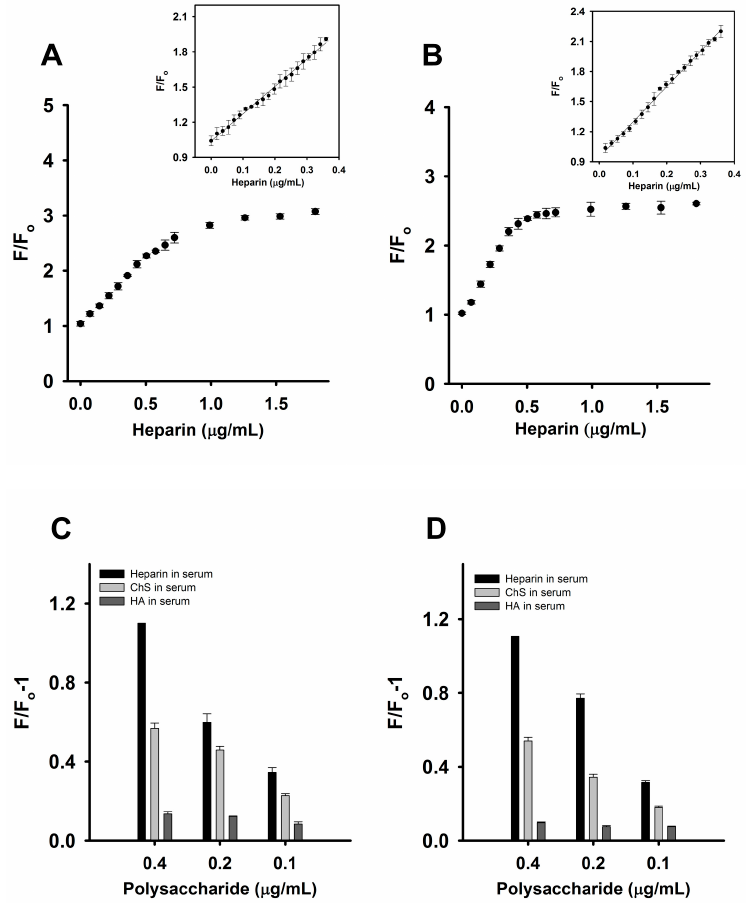
Figure 10. Determination of heparin in plasma samples: Fo and F corresponded to the fluorescence intensity of FAM at 520 nm in the absence or presence of heparin, respectively. ( A ) changes in the fluorescence intensity of solutions of 20 nM aptamer and 300 nM CTX3 in the presence of heparin-spiked plasma samples. (Inset) A plot of the F/Fo value versus the spiked concentrations of heparin; ( B ) changes in the fluorescence intensity of solutions of 10 nM MB and 200 nM CTX3 in the presence of heparin-spiked plasma samples. (Inset) A plot of the F/Fo value versus the spiked concentrations of heparin. Changes in the fluorescence intensity of ( C ) CTX3-aptamer and ( D ) CTX3-MB sensors upon the addition of heparin-, ChS- and HA-spiked plasma samples. Fo and F corresponded to the fluorescence intensity at 520 nm of FAM as measured from CTX3-aptamer and CTX3-MB sensor in the absence or presence of plasma samples spiked with indicated heparin, ChS and HA